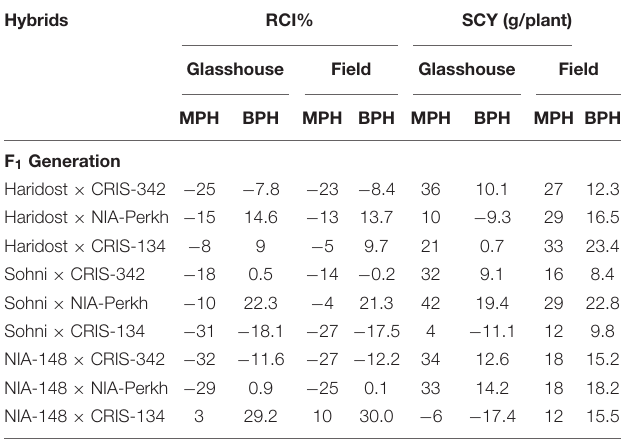
TABLE 6 | Heterotic effects for RCI% and SCY (g/plant) in F 1 generation. Hybrids RCI% SCY